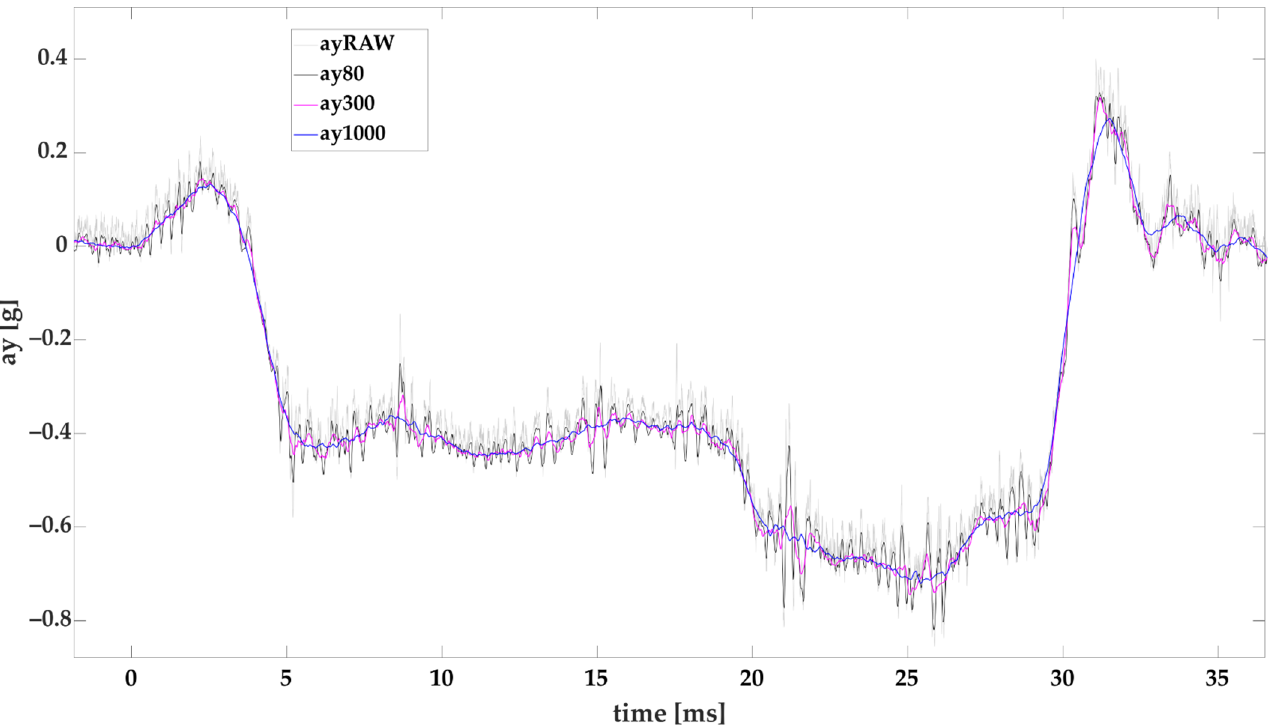
Figure 1. Effect of evaluation time on the lateral acceleration obtained from IMU during a vehicle’s cornering ( 𝑎𝑦𝑅𝐴𝑊 -raw data, 𝑎𝑦80 , 𝑎𝑦300 , 𝑎𝑦1000 —evaluation times 80, 300, and 1000